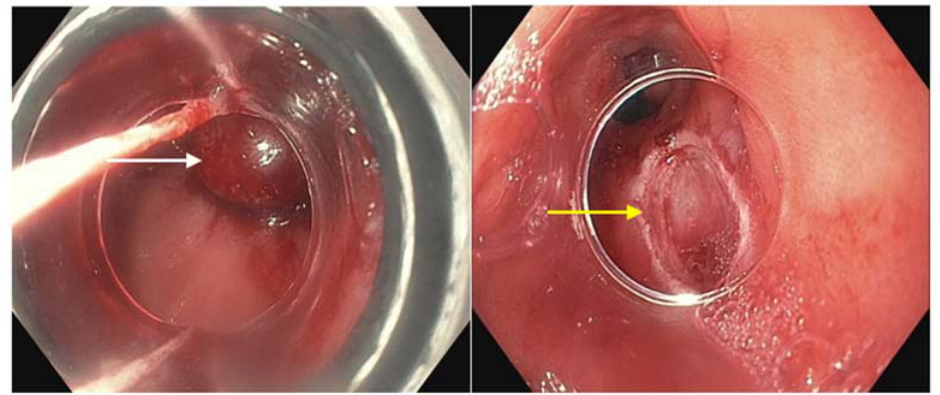
Figure 2. Endoscopic mucosal resection of a dysplastic segment (( left ), white arrow) and exposed area of submucosa following EMR treatment, also known as a post ‐ EMR defect (( right ), yellow arrow).